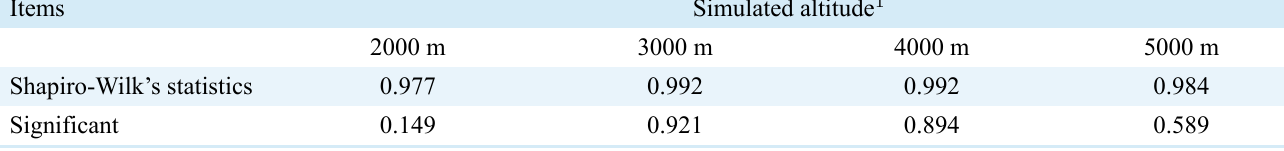
TABLE 11. Results of normality test for each regression model.